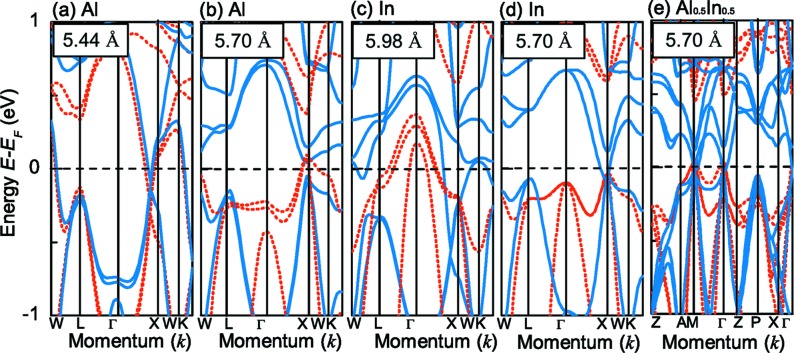
Band structures for FeMnAl with lattice parameters at 5.44 Å (a) and 5.70 Å (b), for FeMnIn at 5.98 Å (c) and 5.70 Å (d), and for FeMnAl0.5In0.5 at 5.70 Å (e) based on the GGA.